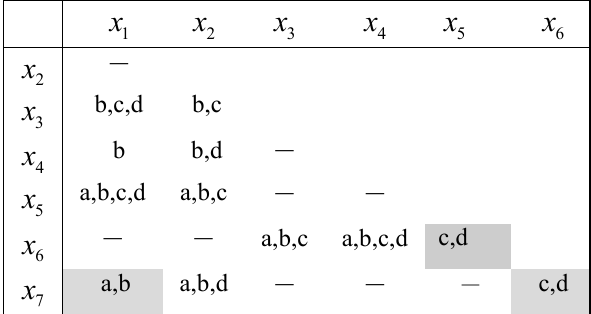
Fig.2. Dicernibility matrix of the decision table in Table